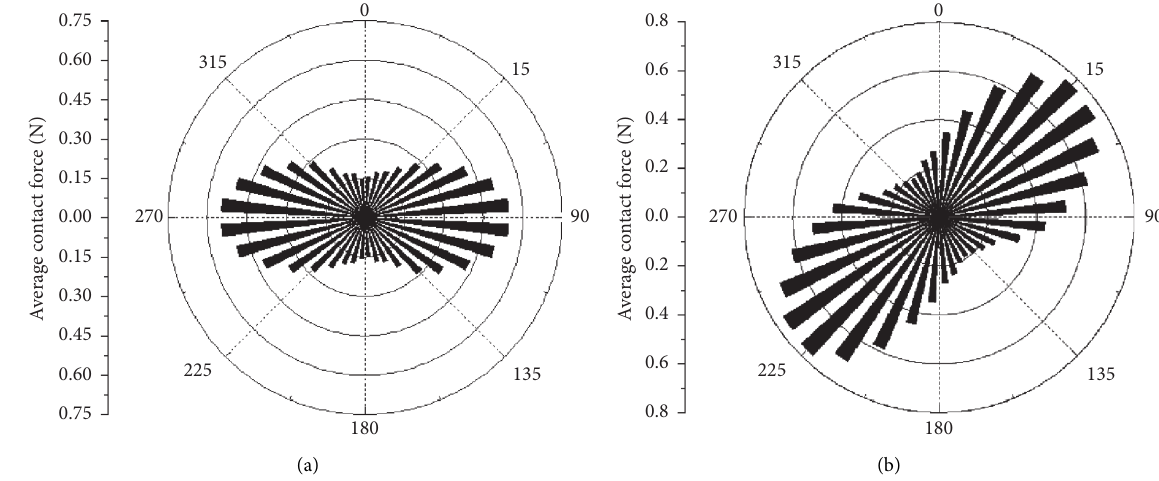
Figure 12: Qualitative distribution of average contact force: (a) after consolidation; (b) at 40% shear strain.